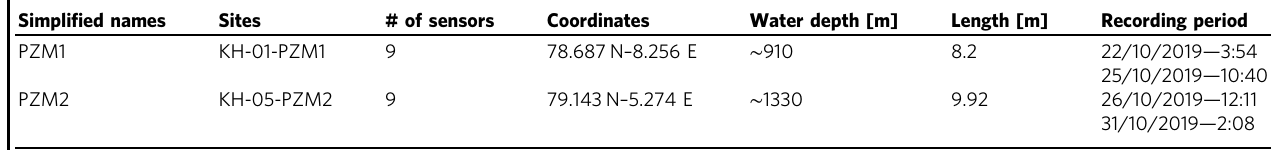
Table 1 Piezometer stations. Simpli fi ed names